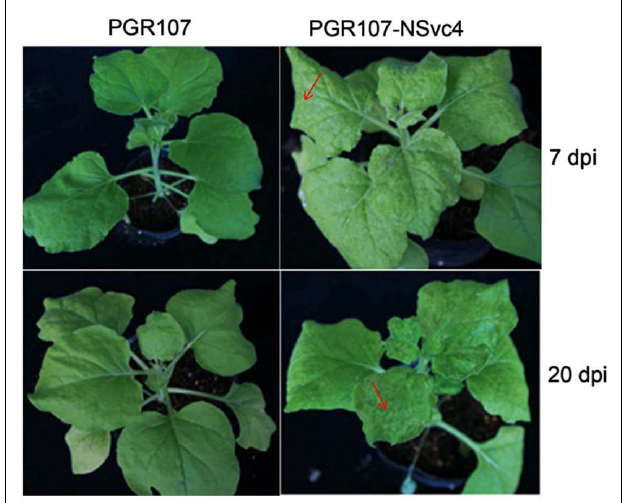
FIGURE 8 | Symptom expression in N. benthamiana plants after infection with the wild type PVX vector or the NSVc4 expressing PVX vector. N. benthamiana plants were infiltrated with pgR107 (wild type PVX) or pgR107-NSvc4 (PVX expressing NSvc4) at 7 or at 20dpi. Allows showed the foliar necrosis in pgR107-NSvc4 infected N. benthamiana .